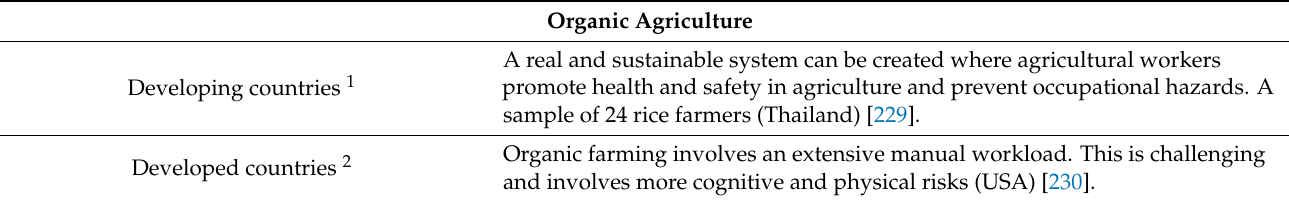
Table A17. MSD research in agriculture (1995–2020). Category: Organic